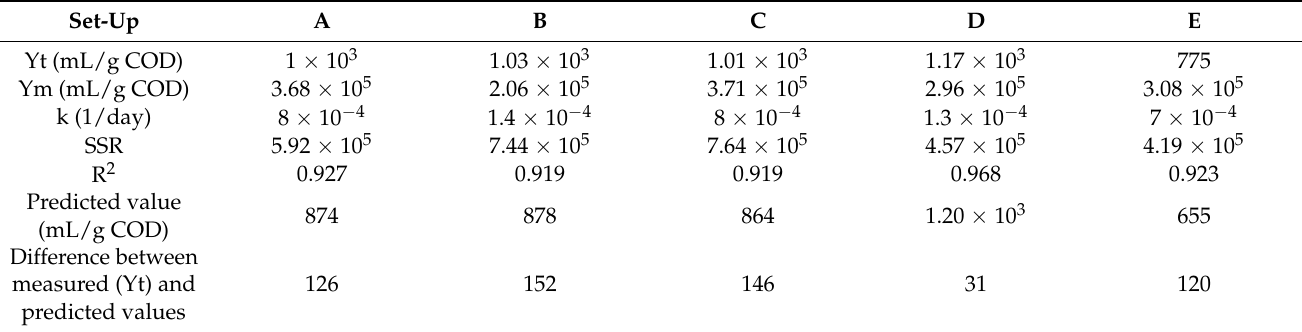
Figure 6. Cumulative biogas yield for bioreactors A–E for HRT of 30 days. Table 5. Summary of the First order kinetic models for bioreactors